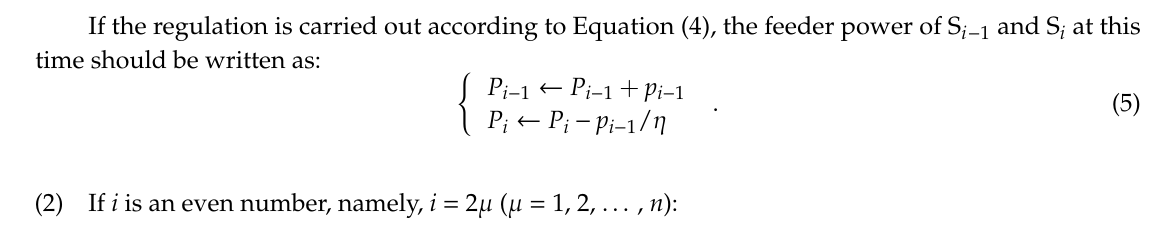
Figure 7. The ETC transfers regenerative braking power to the adjacent power supply sector: ( a ) i is an odd number and ( b ) i is an even number.